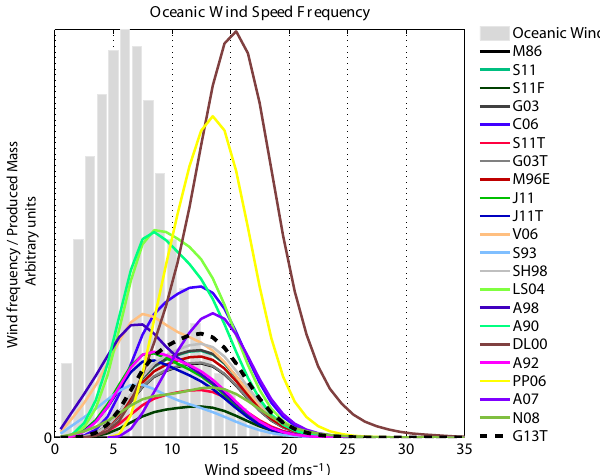
Fig. 6. Histogram of global oceanic 3h, 10m wind speed U 10 in the 25yr of ECMWF data (gray bars) used to calculate SSA produc- tion. The resulting mass globally produced at each wind speed is obtained by accounting for the wind dependencies of production in Fig. 2 for the 22 different source functions (colored curves). The to- tal area under each curve is the logarithm of the total mass produced annually by each